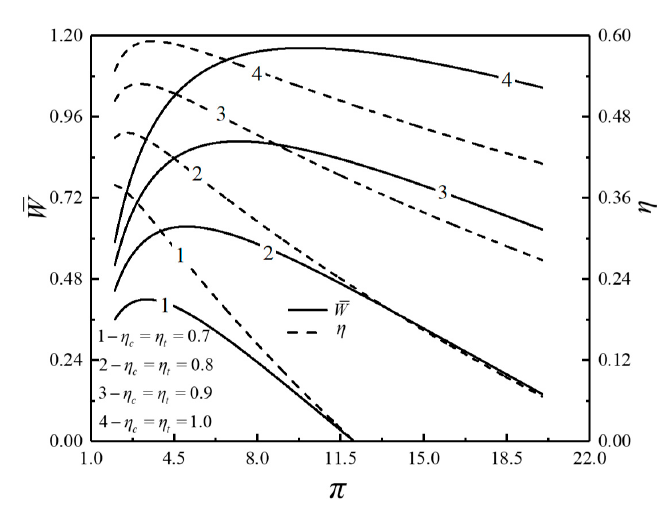
Entropy 2020 , 22 , x Figure 6. Relationships of W and η versus π with di ff erent η c and η t . Figure 6. Relationships of W and η versus